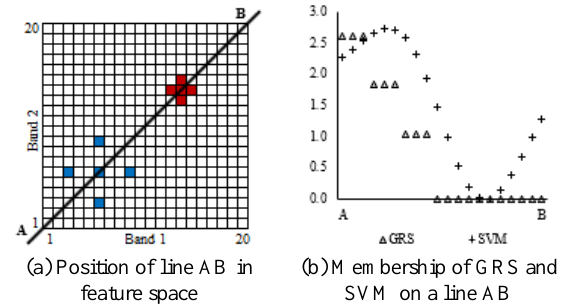
Figure 5. Comparison of class 1 membership between GRS and SVM in Case